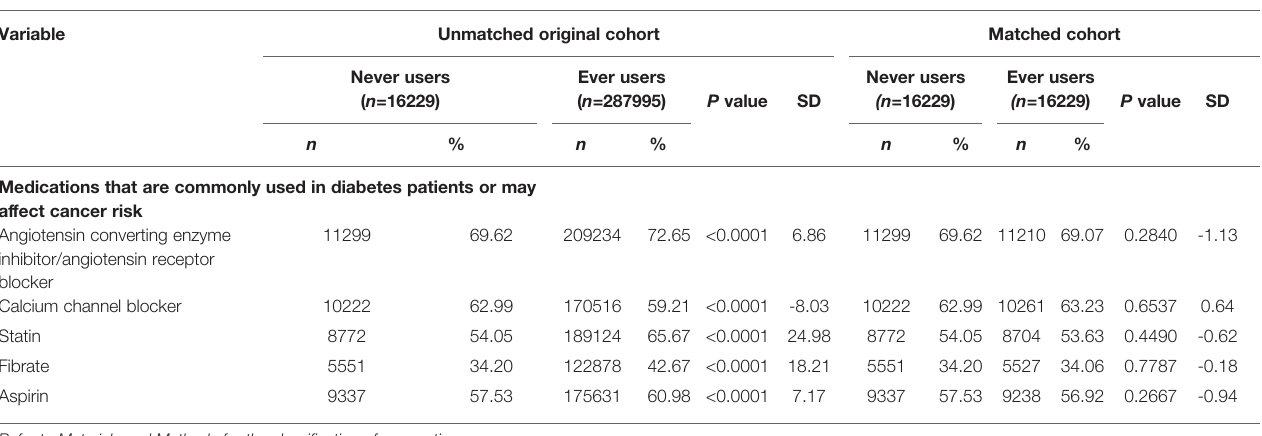
Refer to Materials and Methods for the classi fi cation of occupation. The speci fi c drugs in the class of sulfonylurea include chlorpropamide, glibenclamide, glipizide, gliclazide, glimepiride and gliquidone. *Age is expressed as mean ± standard deviation. SD, standardized